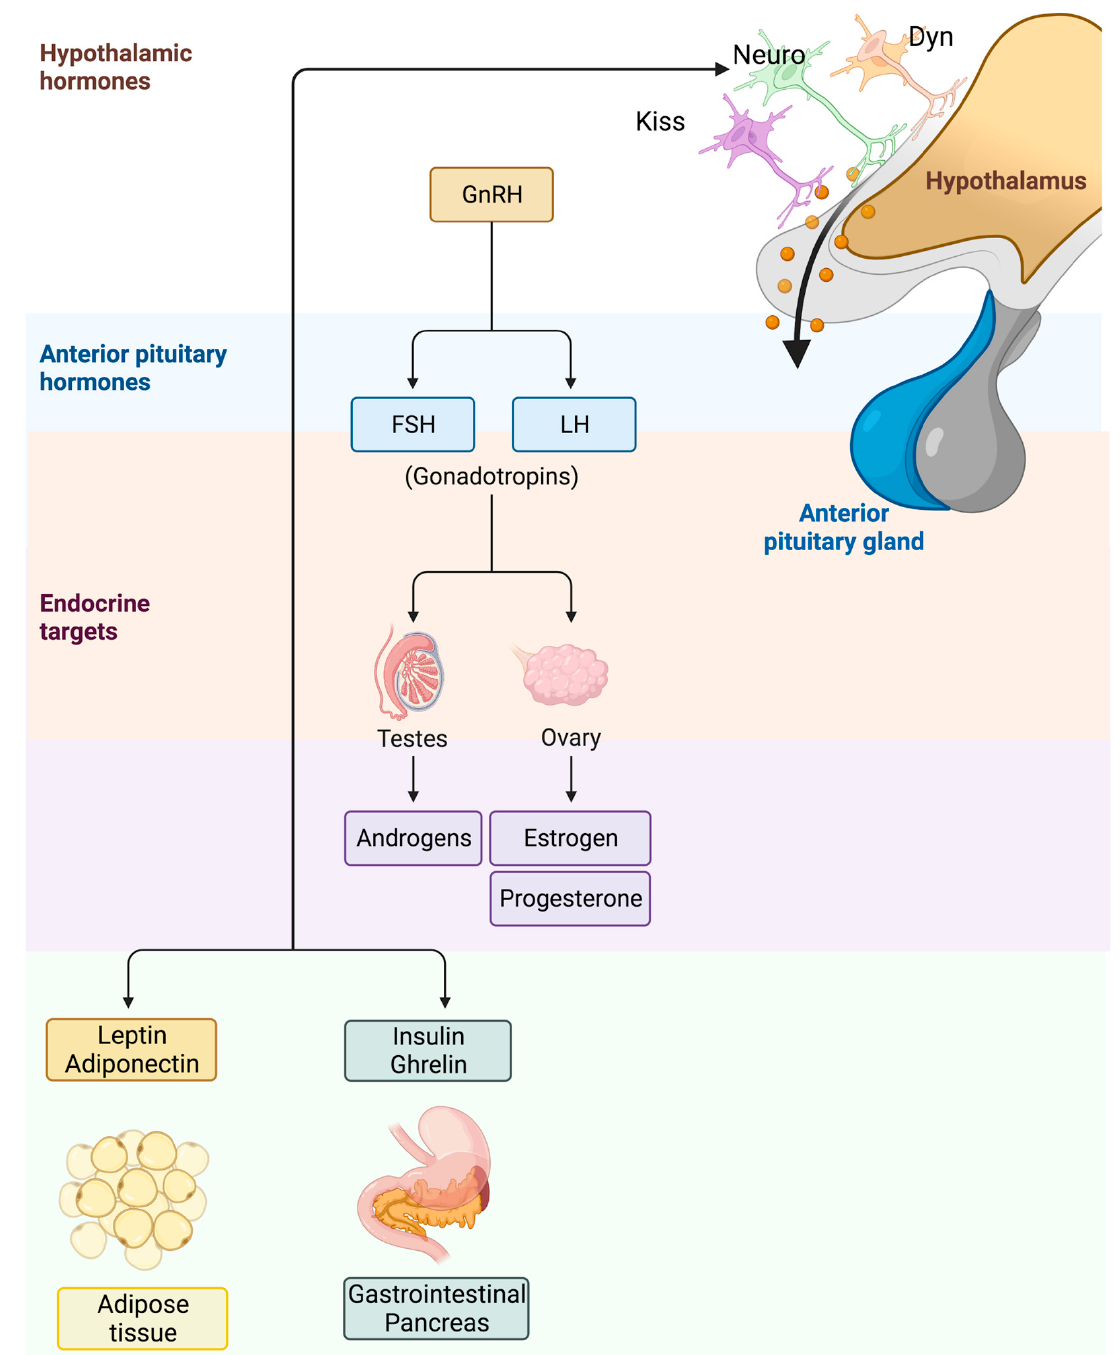
Figure 1. Link between obesity and the activation of the hypothalamic–pituitary–gonadal (HPG) axis. Peripheral signals deregulated in subjects with obesity, such as leptin, adiponectin, insulin, and ghrelin levels, are involved in the regulation of the HPG axis, influencing timing of puberty.